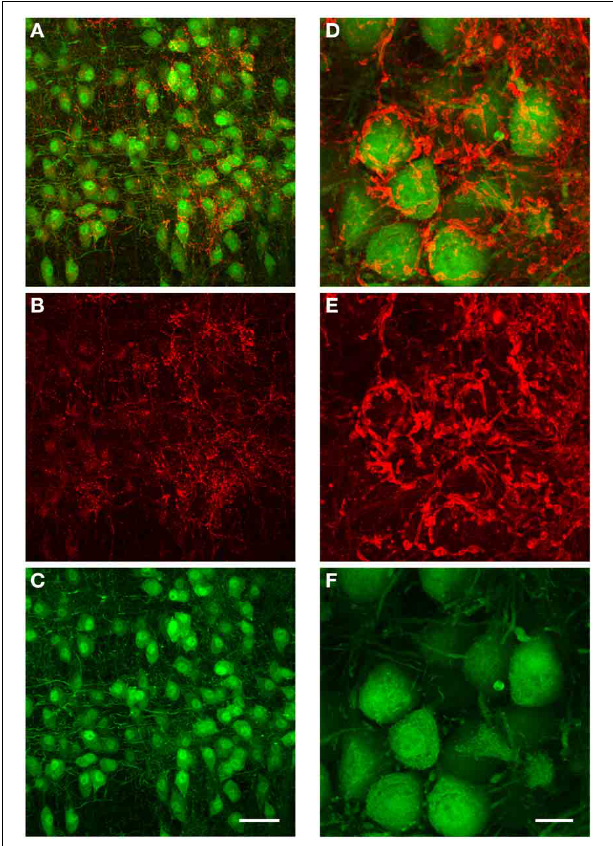
FIGURE 8 | Immunohistochemical labeling against GlyT2 protein reveals complex inhibitory synaptic structures surrounding MNTB principal neurons. All images are maximum projections of a confocal stack [image depth for (A–C) : 40 µ m, for (D–F) : 20 µ m]. The overlay of both channels is displayed in (A) . The antibody labeling against GlyT2 is shown in red (B) and the GFP-expression under the GlyT2-promoter in green (C) . Note that many of the presynaptic terminals labeled by the GlyT2 antibody are highly complex in their structure, and similar to the inhibitory synaptic inputs labeled with the anterograde TMR-injections into the ipsilateral VNTB shown in Figures 6B–D . (D–F) : Higher magnification image (3 × digital zoom) taken in the MNTB of a different GlyT2-GFP mouse. Scale bar for (A–C) : 50 µ m, for (D–F) : 10 µ m. The age of the animal was p59.